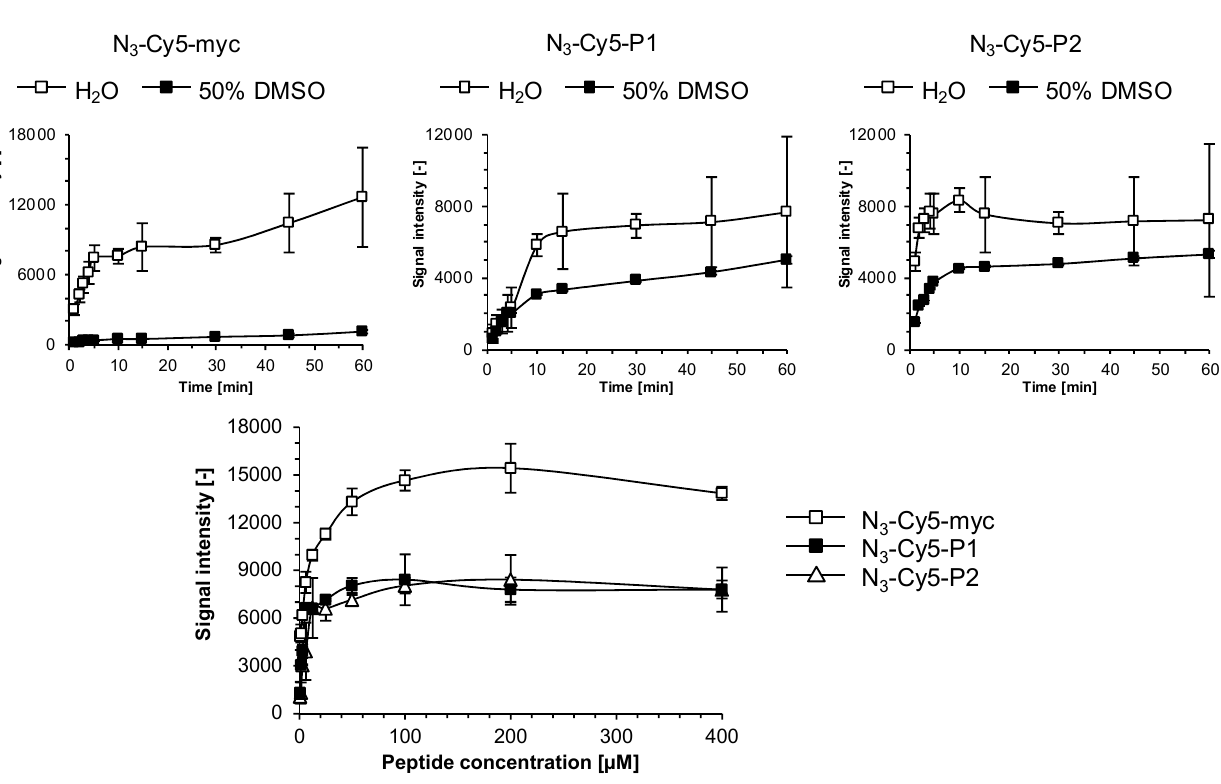
-Cy5-myc, N -Cy5-P1 and N -Cy5-P2 diluted in H O or 3 3 3 2